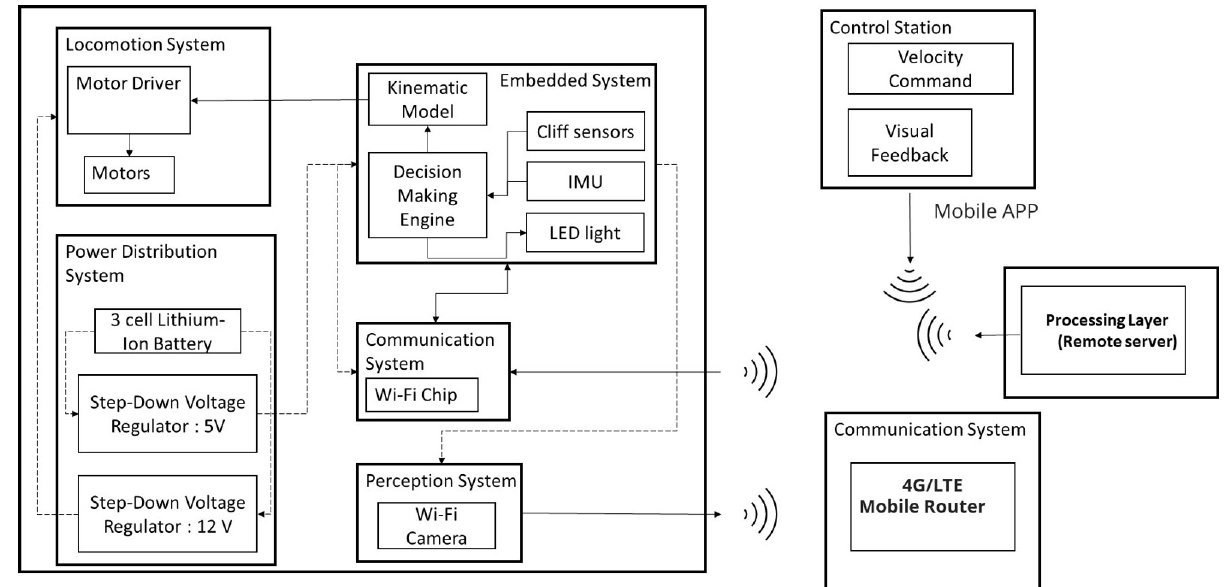
Figure 5. System architecture of